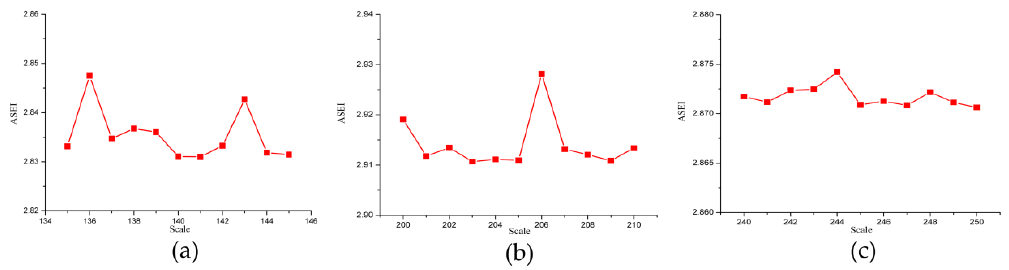
Figure 11. Line chart of the ASEI index for DS2 at scale ranges of ( a ) 135 to 145, ( b ) 200 to 210, and ( c ) 240 to 250.